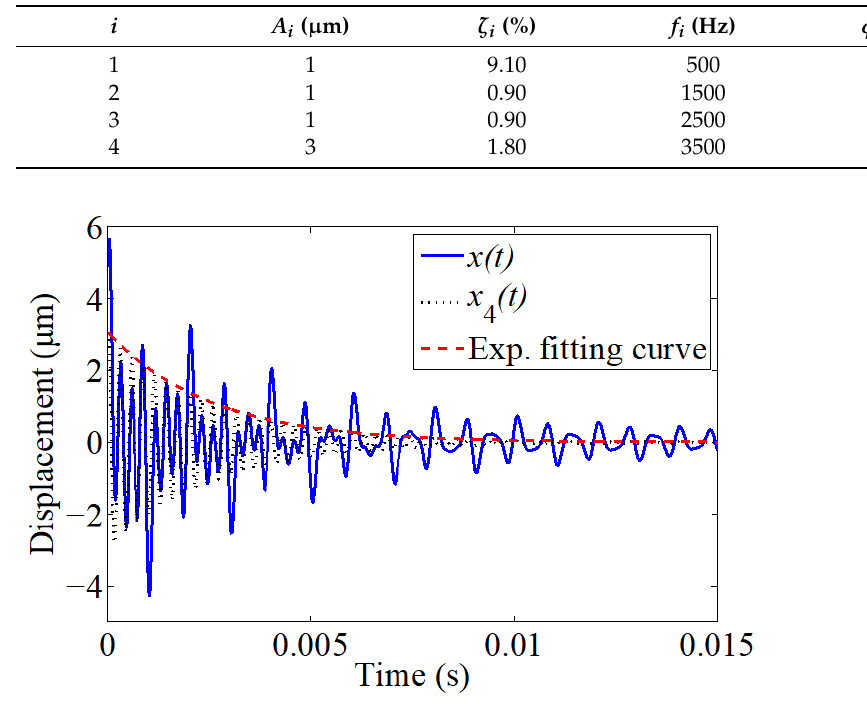
Figure 2. Identified exponential decay curve vs. original signals.